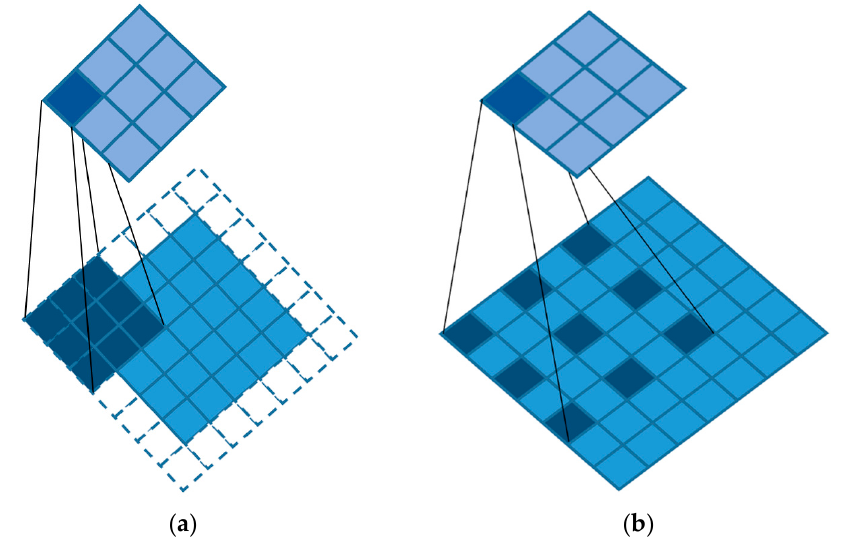
Figure 4. ( a ) Standard convolution with a 3 × 3 kernel. ( b ) Atrous convolution with a 3 × 3 kernel.